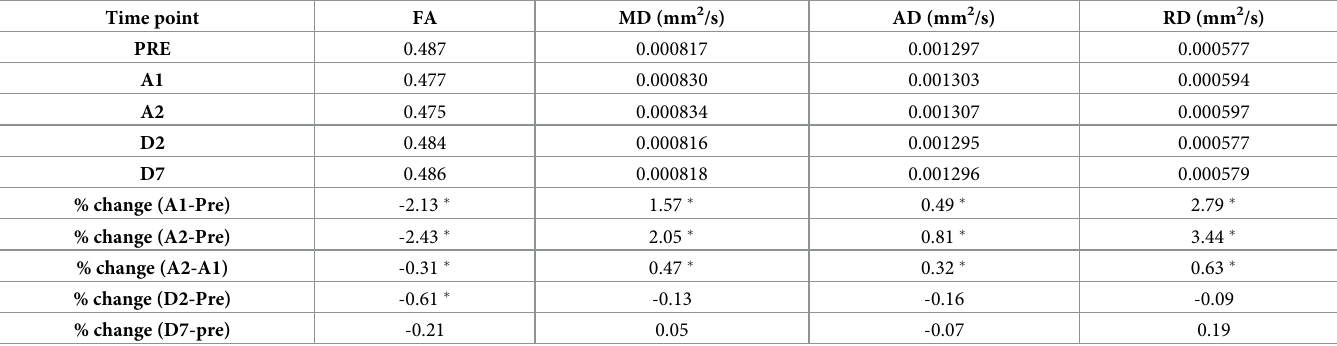
Table 1. Top: Whole brain white matter means of DTI metrics (FA, MD, AD and RD) for the 5 time points. Bottom: % change between the time points ( � indicates statistical significance). PRE —before induction of anesthesia, A1– 40 mins, A2 –100 mins after induction of anesthesia, D2 – 24hrs after general anesthesia, D7 –7 days after general